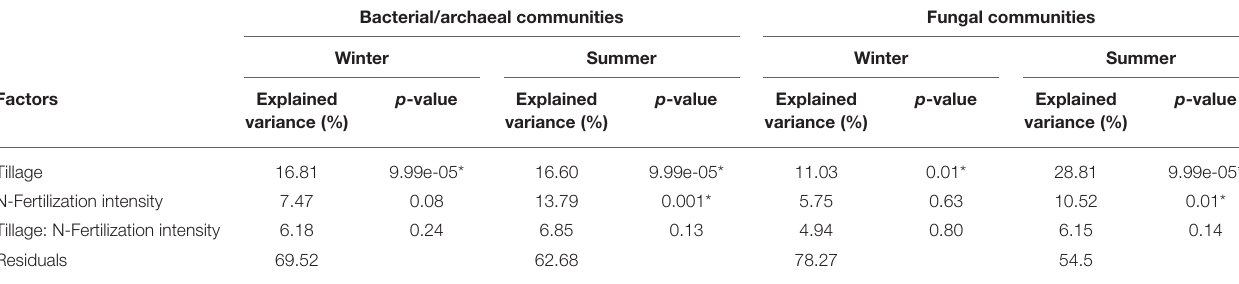
TABLE 3 | Effect of long-term tillage practice and N-fertilization intensity on soil microbial communities in LTE Bernburg. Bacterial/archaeal